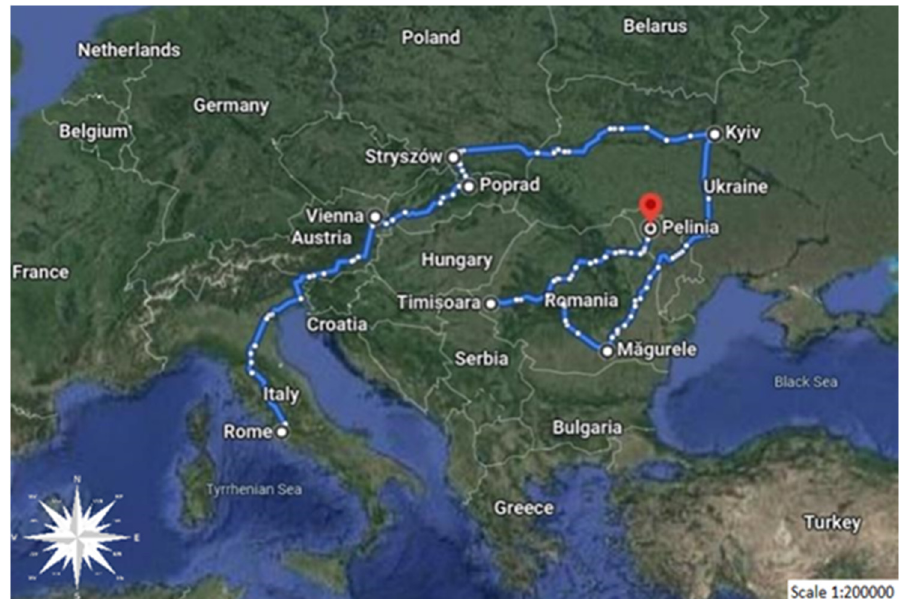
Figure 3. Southeastern Europe: locations of AOD measuring stations.